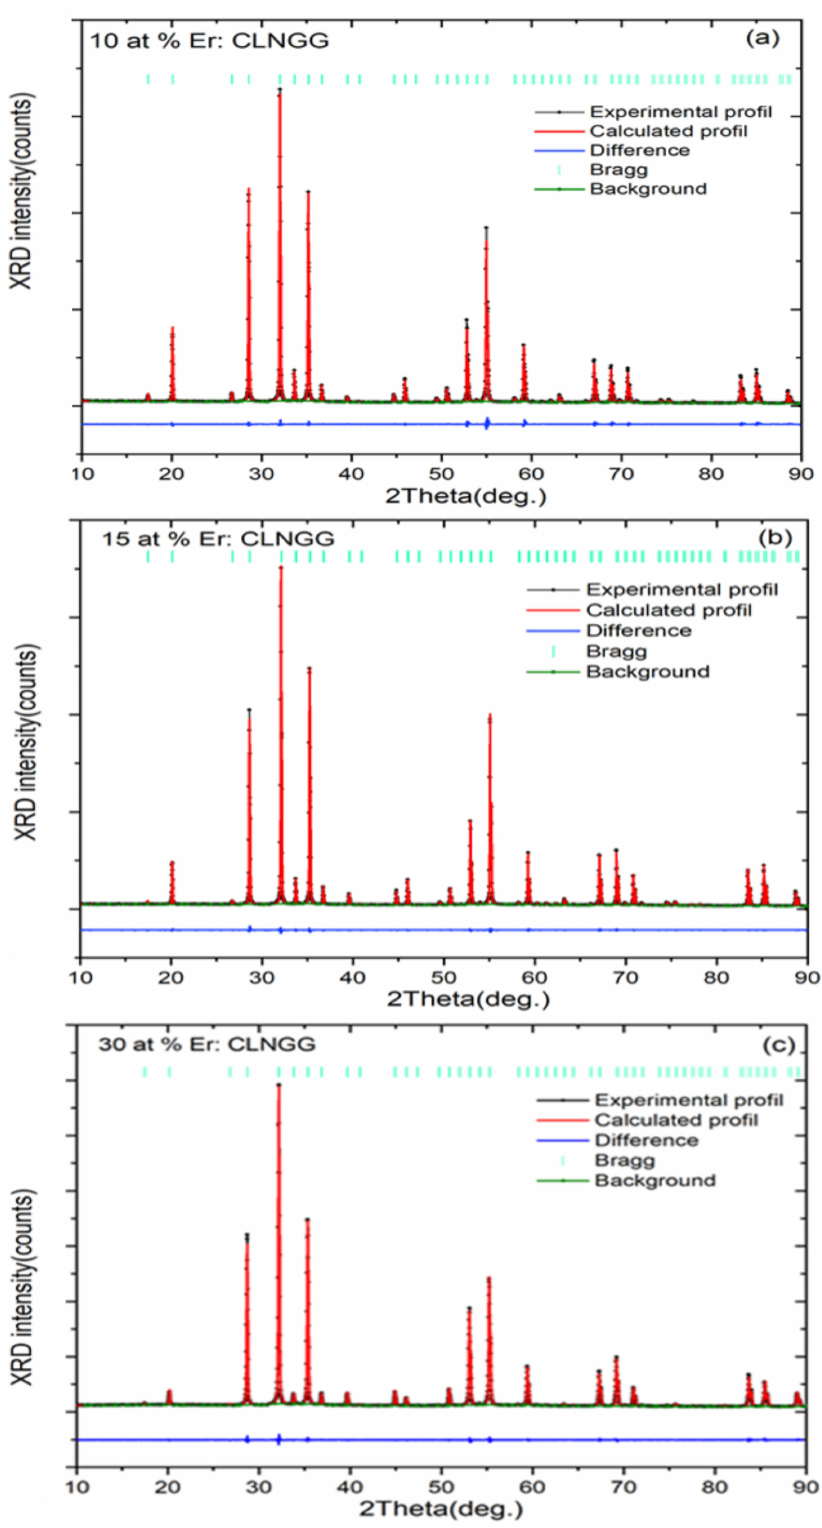
Figure 3. Rietveld structure refinement plots for: ( a ) 10 at.% Er: CLNGG ( b ) 15 at.% Er: CLNGG ( c ) 30 at.% Er: